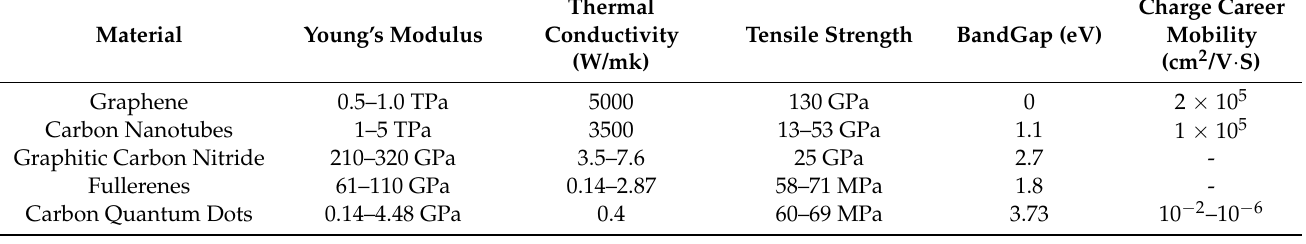
Table 1. Physical and chemical properties of CNMs.